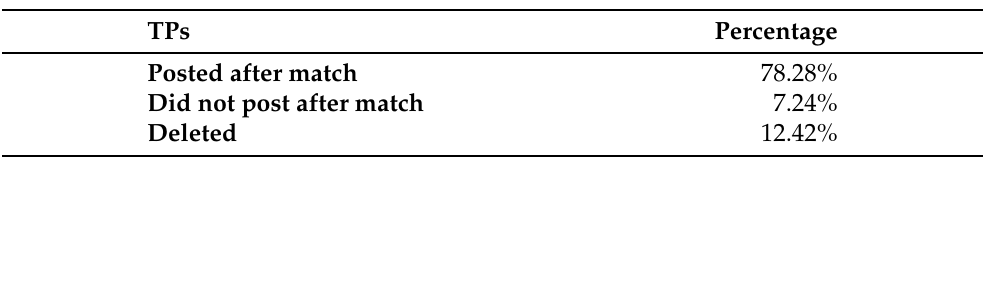
Table 3. User activity distribution among